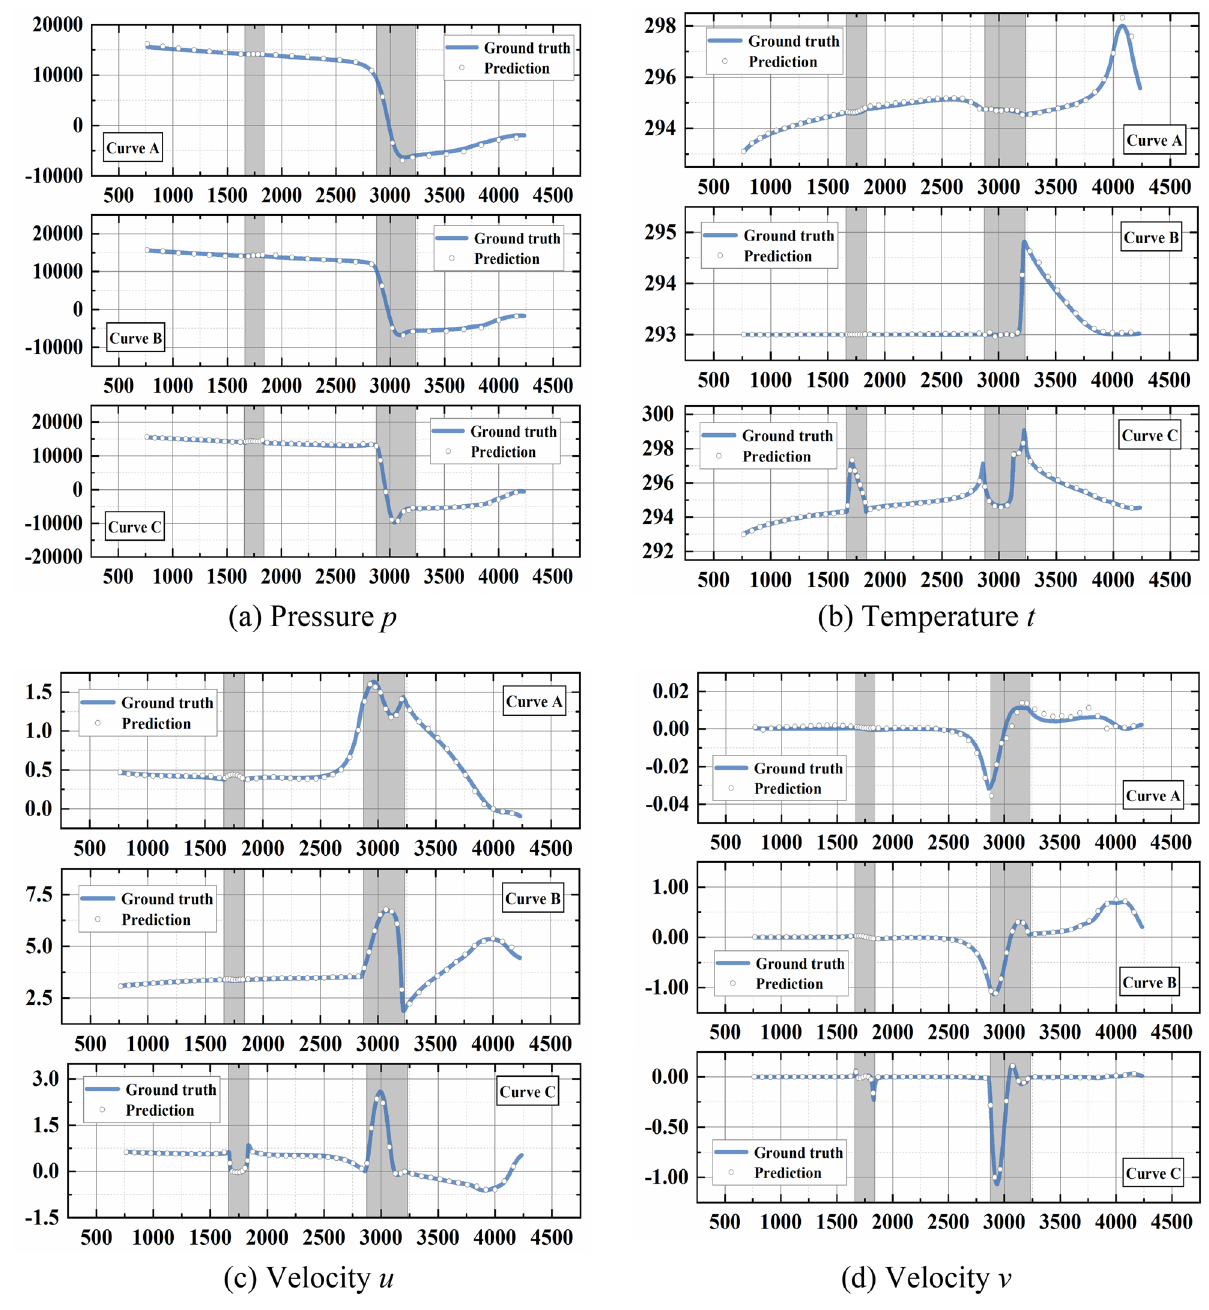
Figure 5. The detailed distributions along curve A, B and